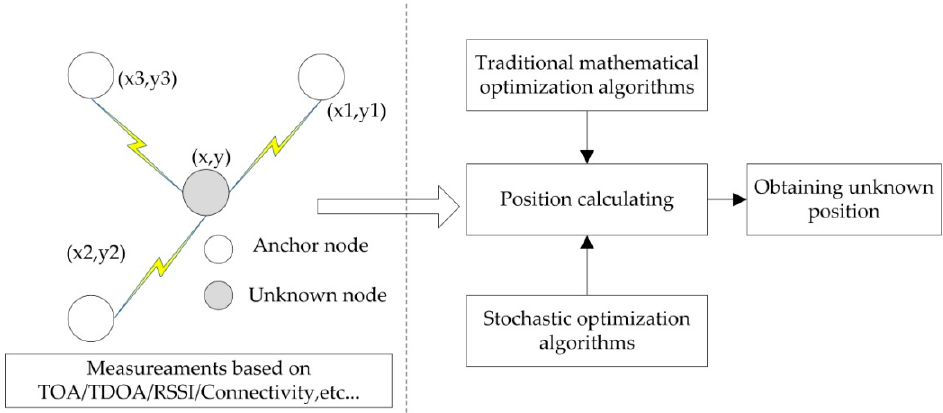
Figure 1. Node localization process in WSN.